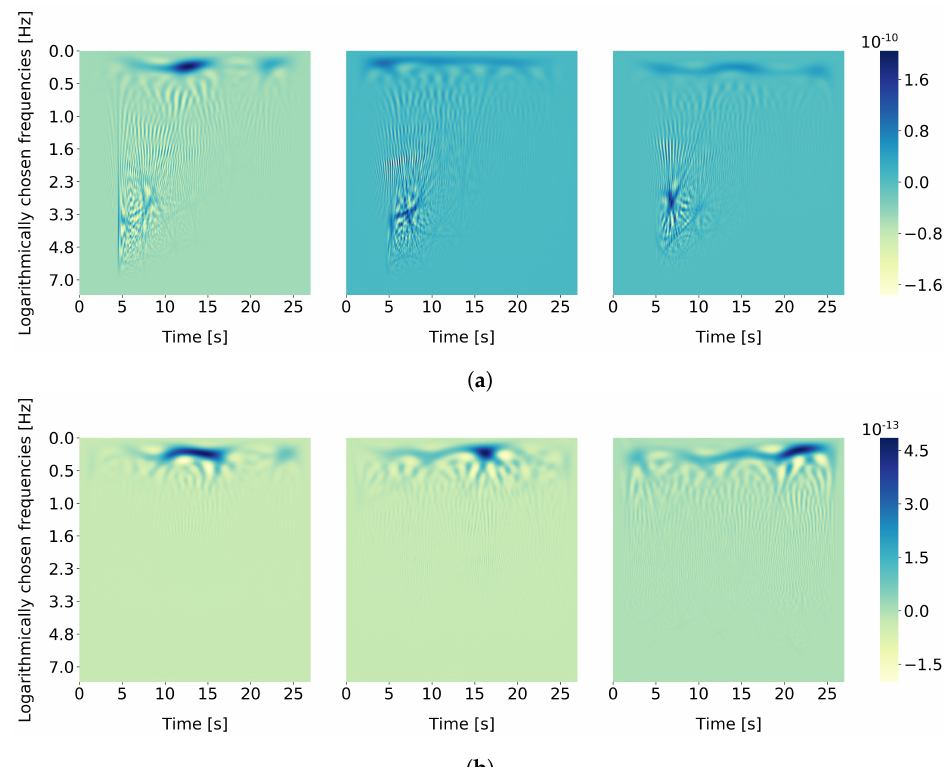
Figure 3. Pseudo Wigner–Ville transformations of ( a ) an earthquake and ( b ) noise shown in Figure 2. All three axes are presented.